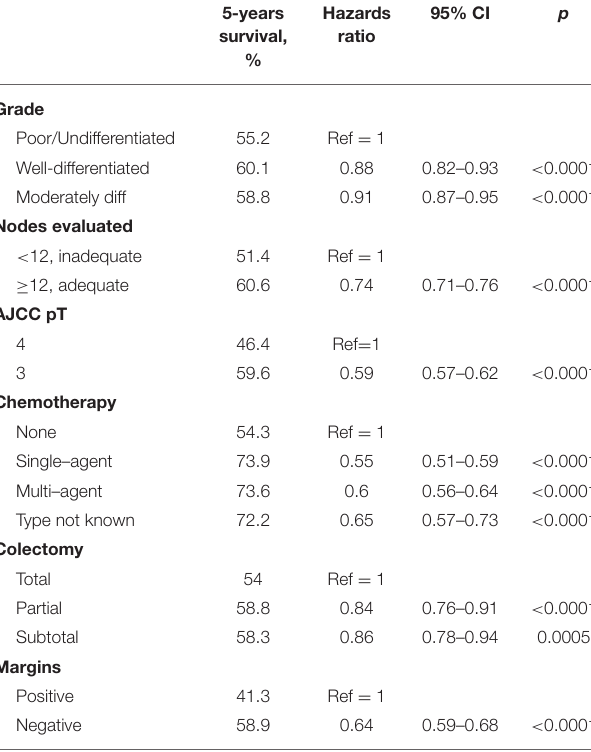
TABLE 4 | 5-years overall survival analysis using Cox proportional hazards regression